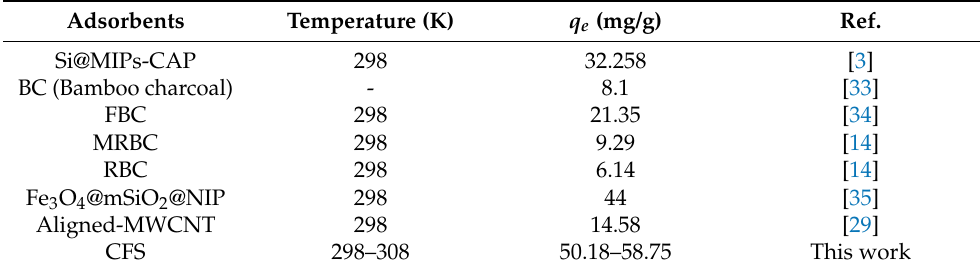
Table 2. Previous studies on the adsorption of CAPC with different